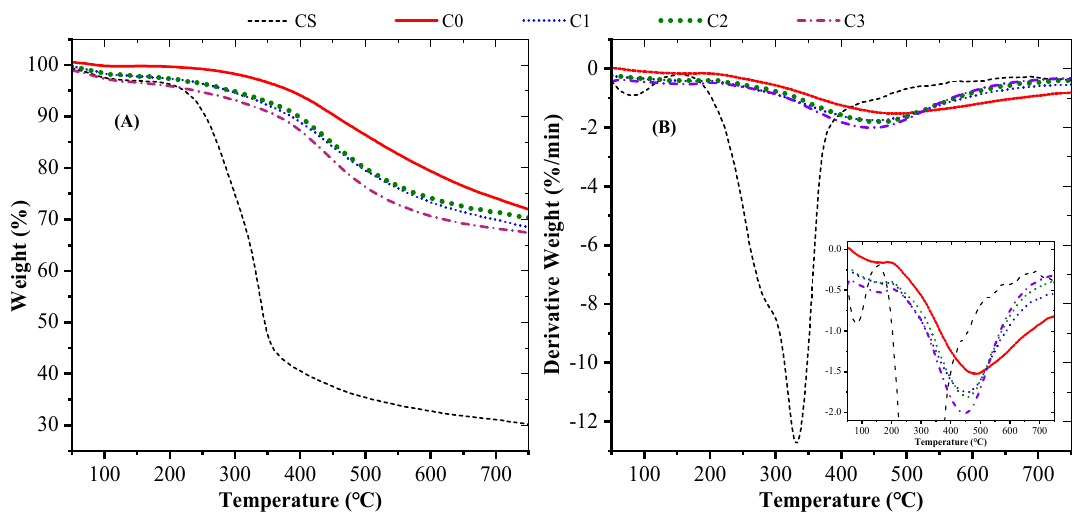
Figure 3. Thermal gravity analysis ( A ) and differential thermal gravity analysis ( B ) of NDS.